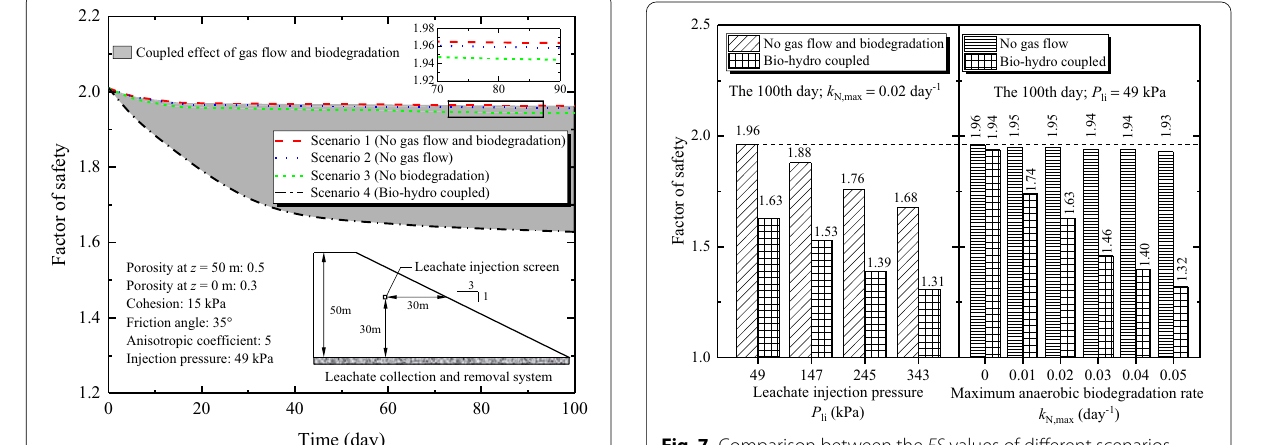
Fig. 7 Comparison between the FS values of different scenarios on the 100th day for 9 pairs of leachate injection pressure P li , and maximum anaerobic biodegradation rate k